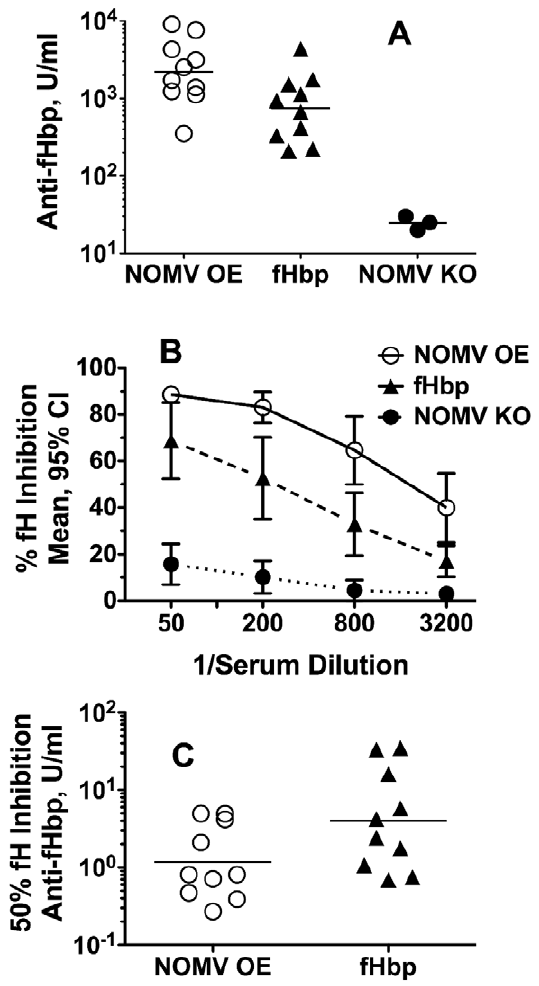
Figure 8. Serum anti-fHbp antibody responses to vaccination as measured by ELISA. Mice were immunized with a recombinant fHbp ID 1 vaccine (filled triangles), or a NOMV vaccine prepared from a mutant of group B strain H44/76 with over-expressed (OE) fHbp ID 1 (open circles), or from a fHbp knock-out (KO) mutant (filled circles). Panel A. Serum anti-fHbp ID 1 antibody concentrations in arbitrary units per ml. NOMV OE vaccine group had a higher geometric mean concentration (horizontal line) than mice immunized with the recombinant fHbp vaccine (p= 0.02). Panel B. Serum anti-fHbp inhibition of binding of fH to fHbp ID 4. At all dilutions tested, the mean percent inhibition of the group given the NOMV vaccine from the mutant with over-expressed fHbp was higher than the recombinant fHbp vaccine group (p , 0.05). Panel C. Serum anti-fHbp ID 1 antibody concentrations for 50% inhibition of binding of fH to fHbp ID 4. The geometric mean was lower for the NOMV OE fHbp group than the recombinant fHbp vaccine group (p , 0.05).